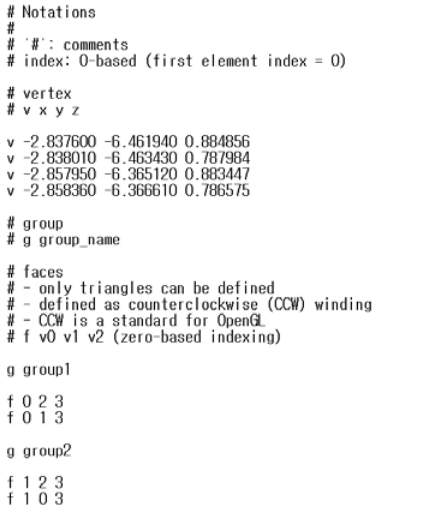
Figure 10. An Example of architectural and non-architectural normal